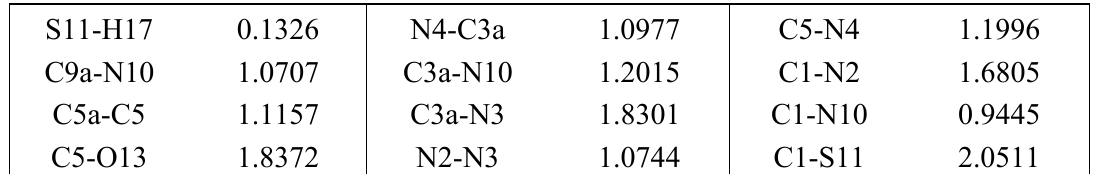
Table 3. Bond orders of selected bonds in the anion form of 3